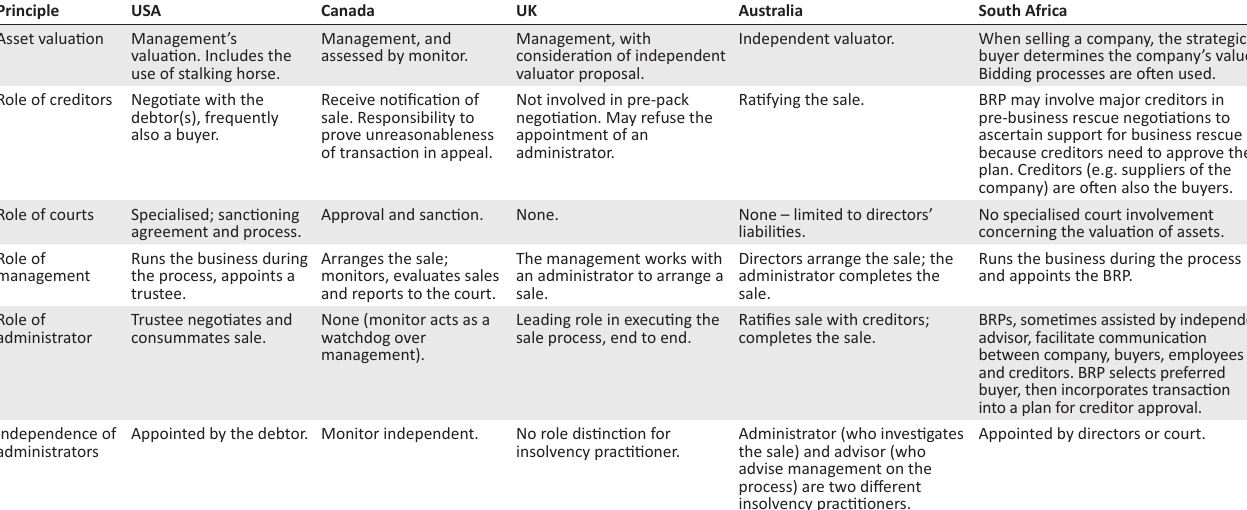
TABLE 3: Asset valuation in international quick sales, including South African sales. Principle Asset